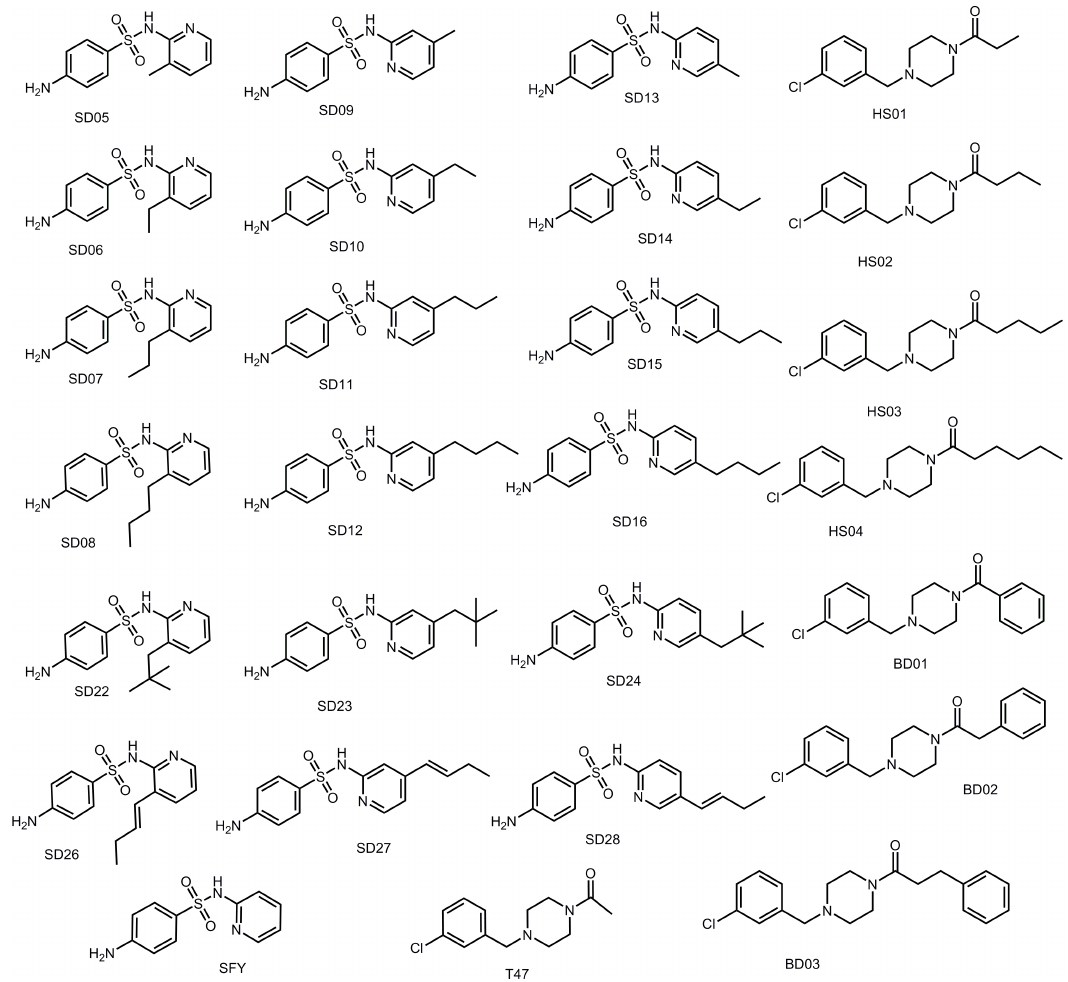
Figure 6. Structures of T47 and SFY compound derivatives designed for aliphatic substituent dataset. Table 4. Docking scores for addition of aliphatic substituents to T47 and SFY compounds.